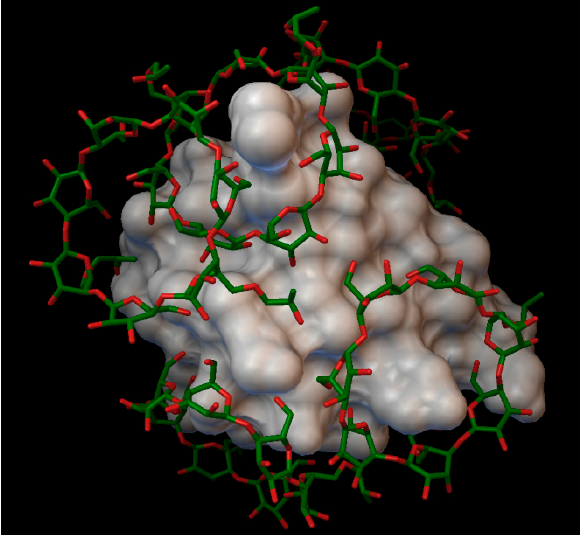
Figure 9. Insulin-hydroxypropyl- β -cyclodextrin (DS 2) complex. The insulin molecular surface is marked with white and the cyclodextrin molecules are marked with green and red licorice.